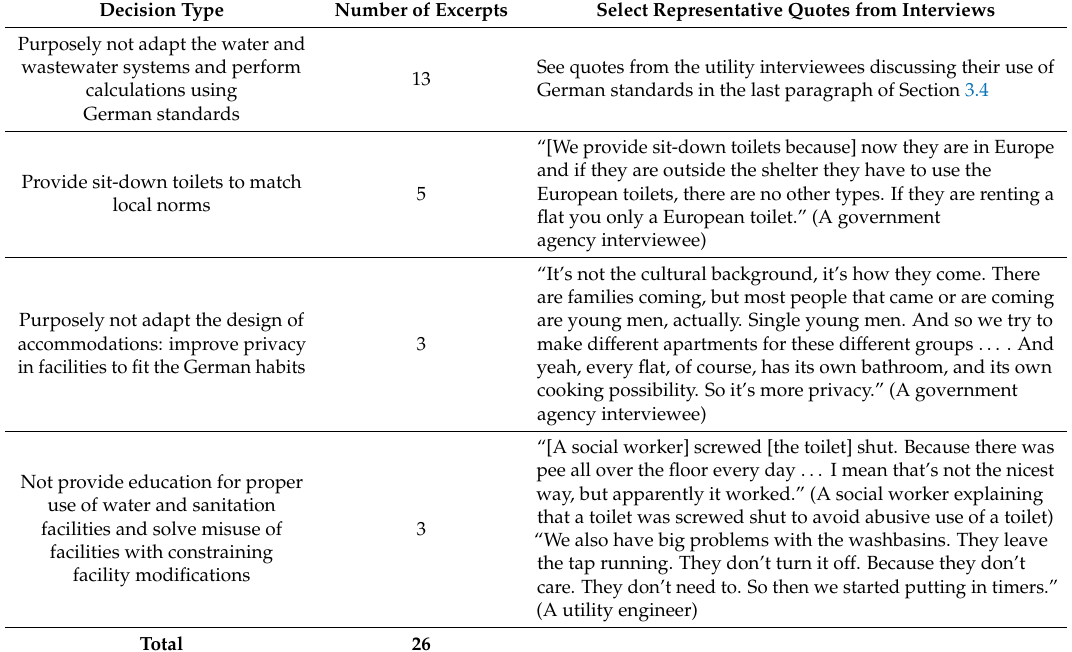
Table 6. Frequency of the types of decisions legitimized by the interviewees while delegitimizing the inclusion of cultural